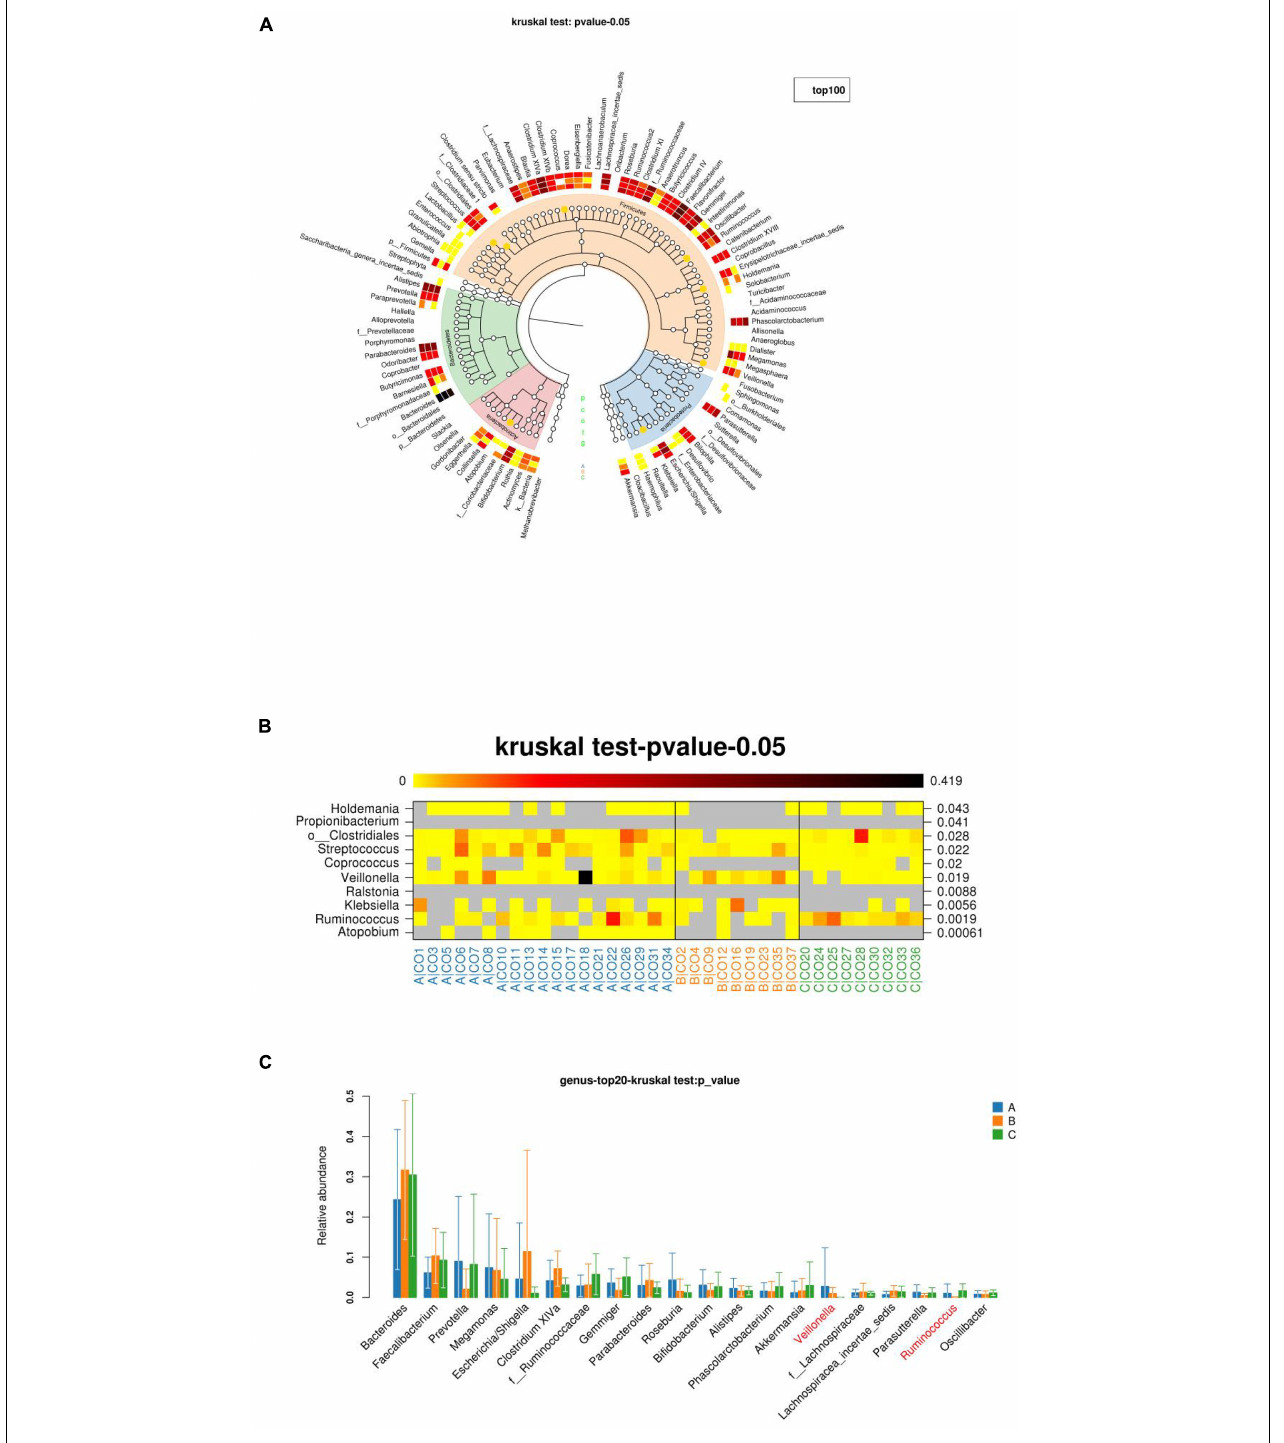
FIGURE 7 | The richness and microbiota structure of the intestinal dominant bacteria in the three groups. (A) Innermost layer is the species classification tree, which contains three types of bottoms used with “gates” on top of color labeling. The orange dots indicate significant differences between the three groups ( Q -values), with a layer of red in the middle. White and white are the average richness heat map, and the darker the color, the greater the abundance. The outermost layer is the injection interpretation of the species. (B) Diagram of the richness of different species. The darker the color, the higher the richness. The left side shows the corresponding species annotation, and the right side shows the p - or Q -values of the statistical test. (C) Top 20 species richness microbiota of the three groups of samples at the species level).